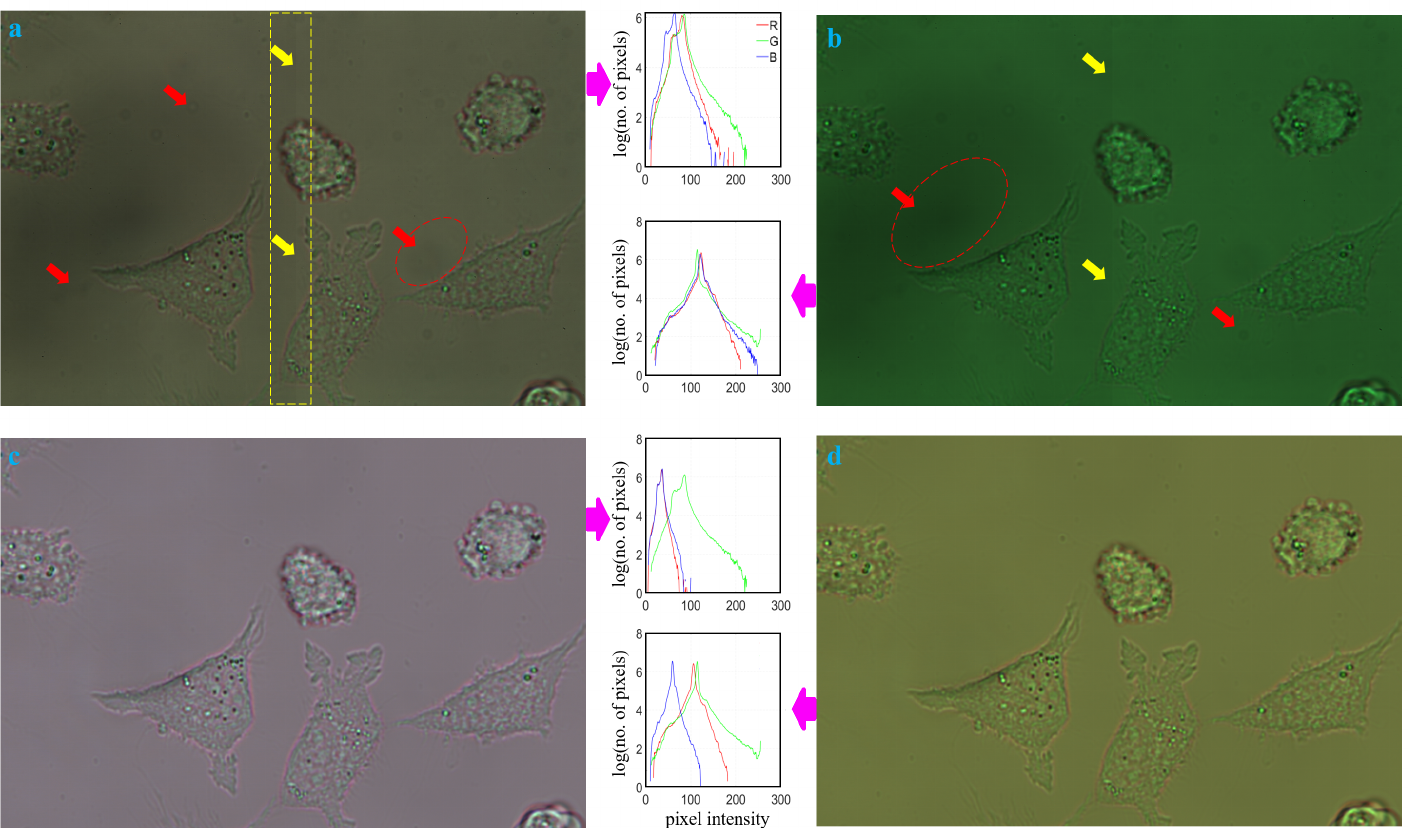
Figure 9. The LIL 8 bpc visualization and their corresponding histograms of uncorrected ( a , b ) and spectrally corrected ( c , d ) image of mouse fibroblasts captured by the nanoscope (40 × objective magnification). The LIL transformation was performed for a single image ( a , c ) and through the whole image series ( b , d ). The yellow and red arrows point to the sensor tap imbalance problem and stains of dirty on the microscope optics, respectively. The magenta arrows refer to the relevant histogram of the images ( a – d